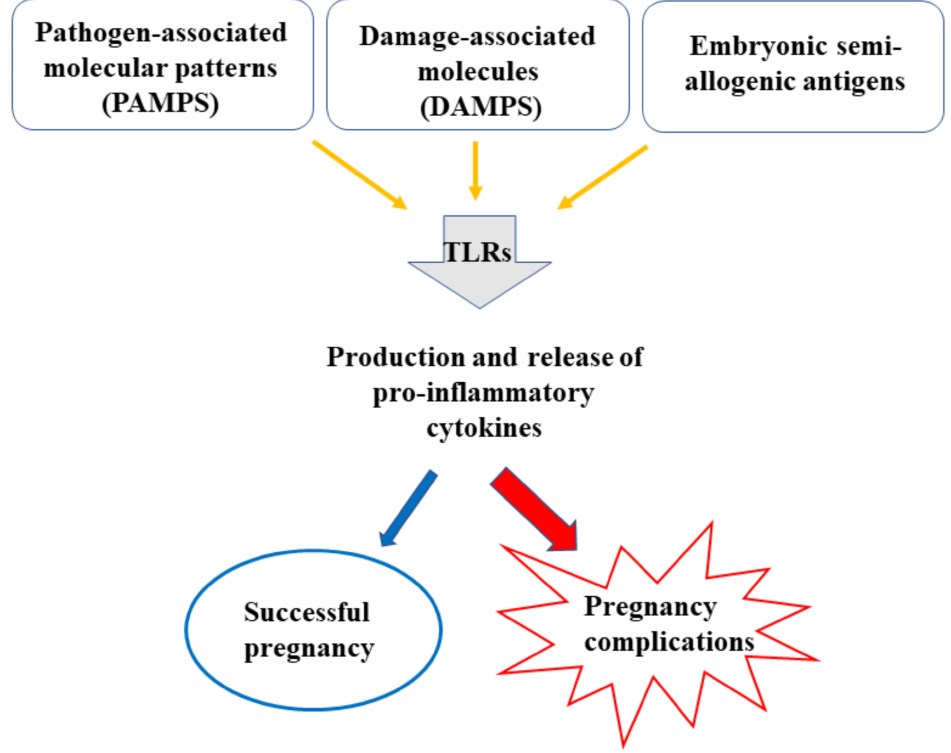
Figure 1. An inflammatory response is essential in pregnancy to protect against infection, repair tissue injury, and promote a tolerogenic milieu for the fetus. An exacerbated inflammatory response can be harmful for pregnancy outcomes causing diseases such as